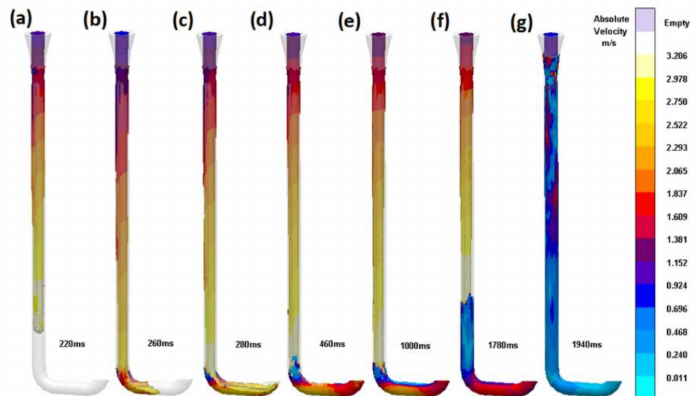
Figure 9. Round, non-tapered sprue (S i 1). Subsequent stages of the flow ( a ) 220 ms, ( b ) 260 ms,